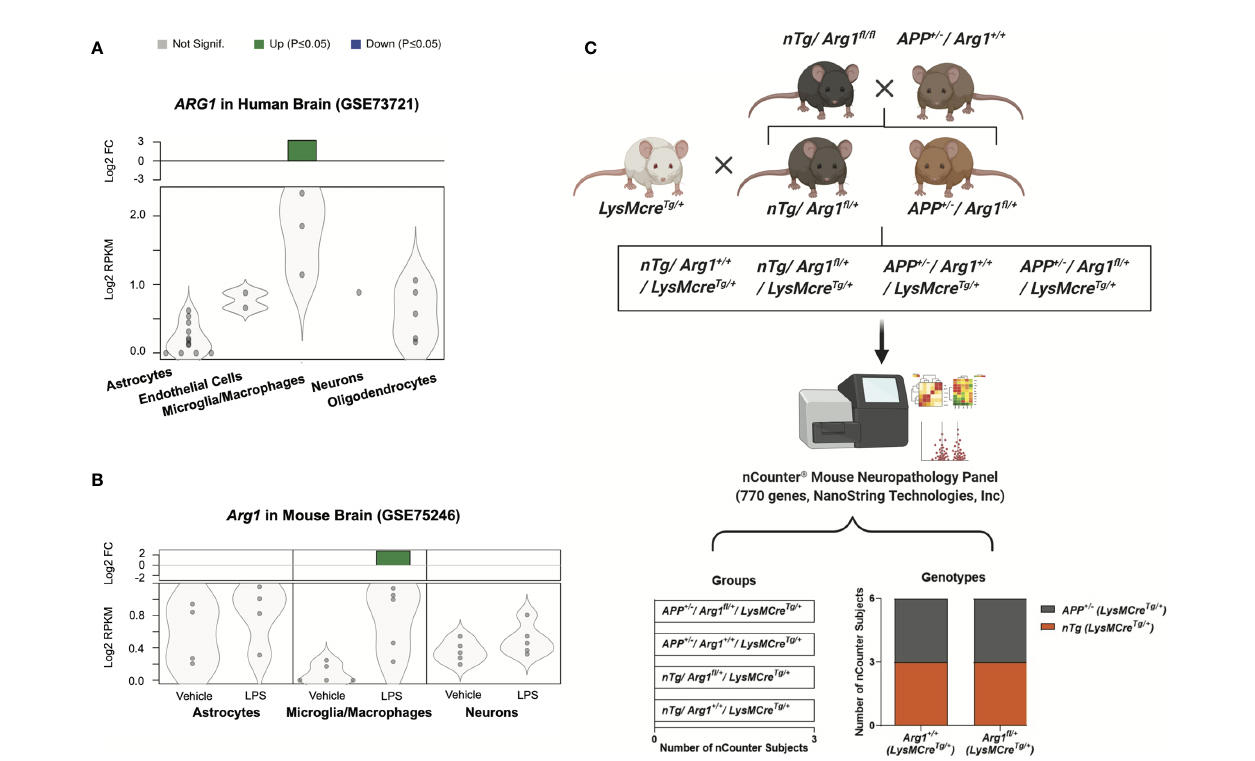
FIGURE 1 | Arginase 1 gene expression in central nervous system cell types and the experimental work fl ow for mouse breeding and gene expression analysis. A search for RNA sequencing data sets enriched for puri fi ed central nervous system cell types from human and mouse brains identi fi ed two studies on arginase 1 expression. Datasets were obtained from the National Center for Biotechnology Information (NCBI) Gene Expression Omnibus (GEO). Gene transcripts were measured by reads per kilobase per million total reads (log2 RPKM) and presented as violin plots with dots representing samples. The green bars at the top indicate signi fi cant up-regulation ( p ≤ 0.05) with the fold change (log2 FC) relative to the control. (A) The human ARG1 gene transcript in puri fi ed cell types of normal adult human brains (GSE73721; Astrocytes, n=12; Endothelial Cells, n=2; Microglia/Macrophages, n=3; Neurons, n=1; Oligodendrocytes, n=5). (B) The Arg1 gene transcript in puri fi ed cell types of normal adult mouse brains injected with LPS (GSE75246; Astrocytes, Microglia/Macrophages, Neurons; Vehicle, n=5; LPS, n=5). (C) The schematic representation of the experimental work fl ow. The APP Tg2576 (APP +/- /Arg1 +/+ ) mice were bred with non-transgenic Arg1 LoxP ( nTg/Arg1 fl / fl ) mice to generate nTg / Arg1 fl /+ mice and APP +/- /Arg1 fl /+ mice. Both were then bred with LysMcre Tg/+ mice to generate a total of four groups for the study. We harvested mouse brain RNA and performed gene expression pro fi ling using the nCounter ® mouse neuropathology panel (770 genes, NanoString Technologies, Inc.). Bioinformatic analyses were performed to investigate the four groups of mice ( nTg/Arg1 +/+ /LysMcre Tg/+ , nTg/Arg1 fl /+ /LysMcre Tg/+ , APP +/- /Arg1 +/+ /LysMcre Tg/+ , APP +/- /Arg1 fl /+ /LysMcre Tg/+ , n=3 samples per group representing 6 mice), which cover two genotypes categorized into the APP transgene genotype ( APP +/- vs nTg ) and the Arg1 haploinsuf fi ciency genotype ( Arg1 fl /+ vs Arg1 +/+